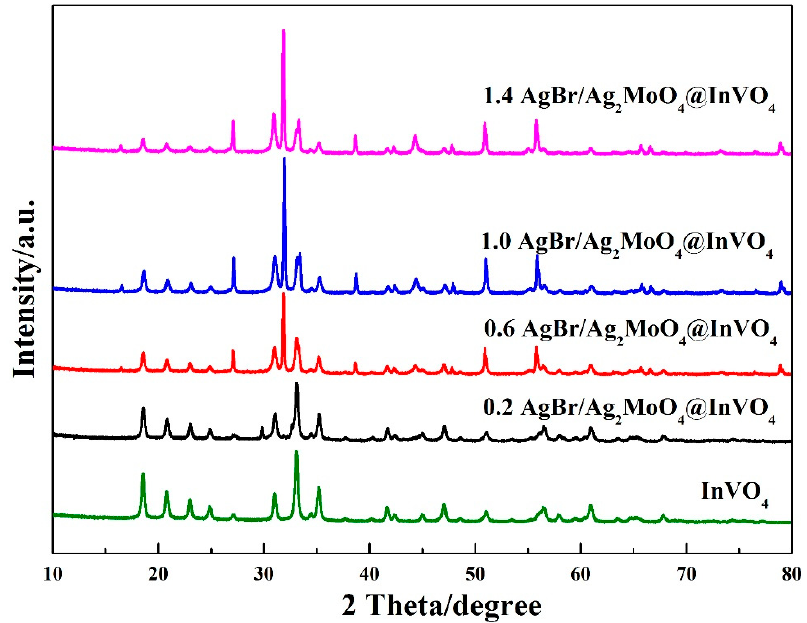
Figure 1. XRD patterns of di ff erent molar ratios of AgBr / Ag 2 MoO 4 @InVO 4 photocatalyst.